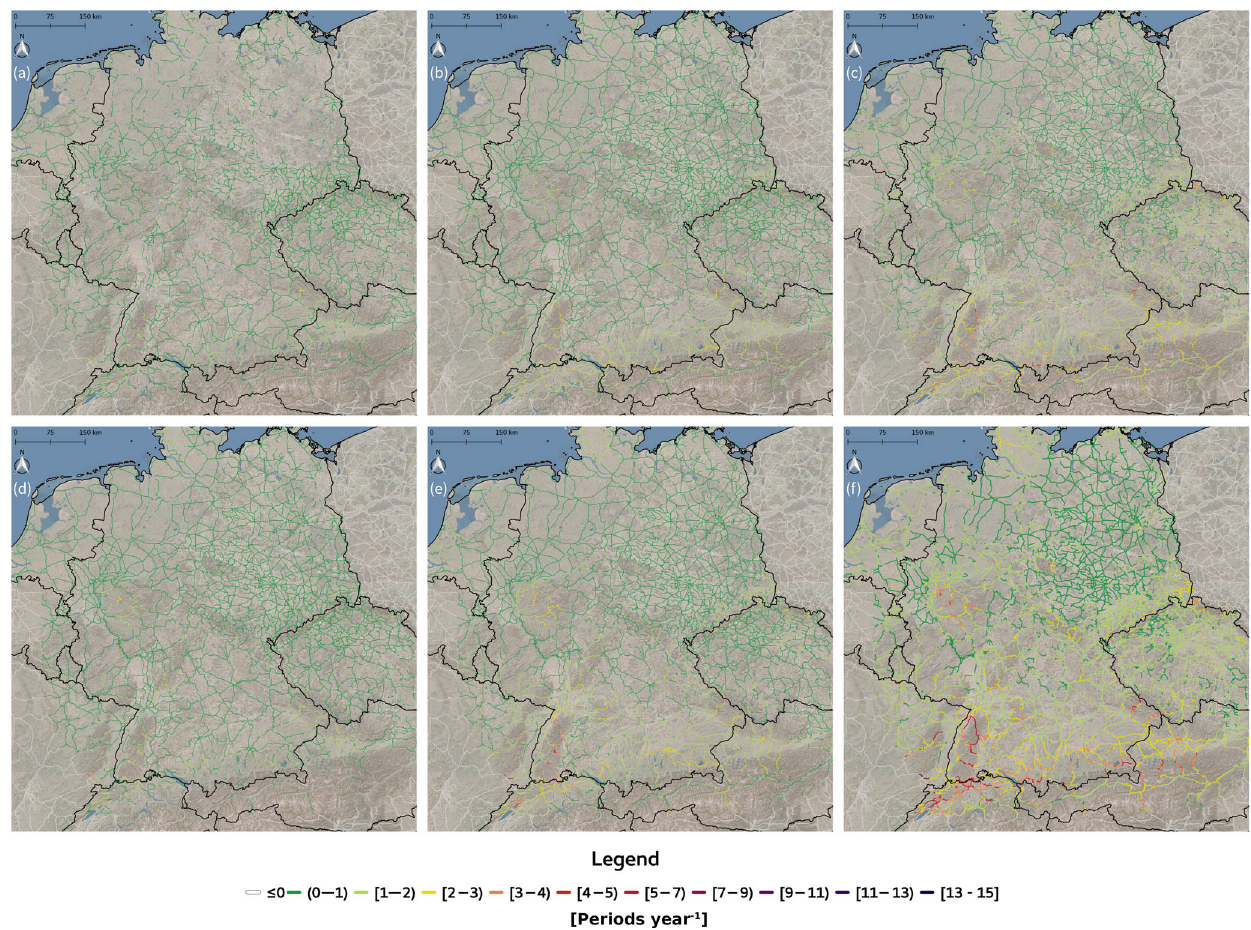
Figure 2. Projected changes in the annual number of periods exceeding rainfall thresholds for the possible occurrence of landslides (pre- cipitation totals > 25.6mmd − 1 and > 37.3mm(3d) − 1 ) concerning the railway network in central Europe. The first row shows near-future projection results and the second row displays projection results for the remote future. The three columns represent the quartiles in increasing order, with (a) and (d) displaying the lower quartile, (b) and (e) displaying the median, and (c) and (f) displaying the upper